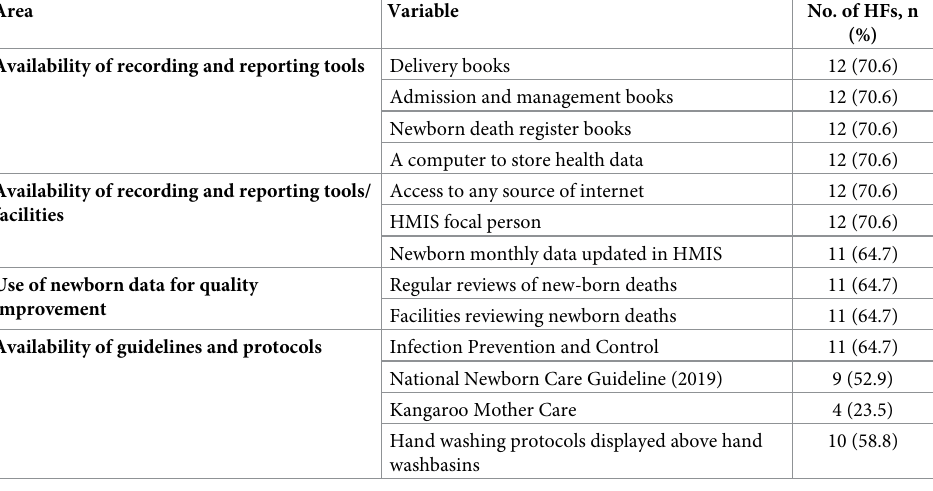
Table 8. Status of recording, reporting, and neonatal care guidelines, (N = 17). Area